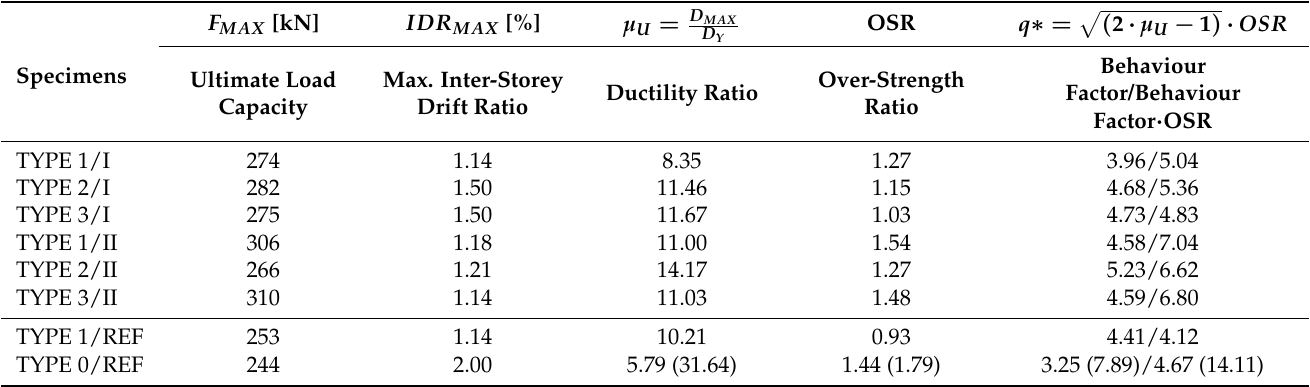
Table 4. Measured ultimate base shear capacity, drifts, ductility, over-strength ratios, and be- haviour